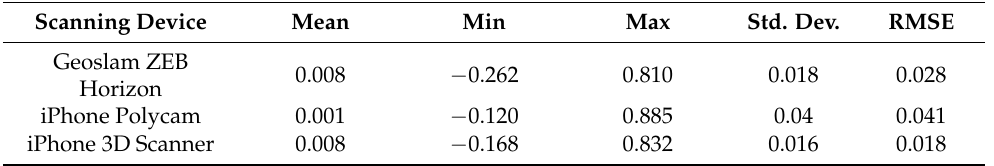
Table 5. Statistical evaluation of differences between digital surface models in comparison with reference model from TLS scanner Faro Focus